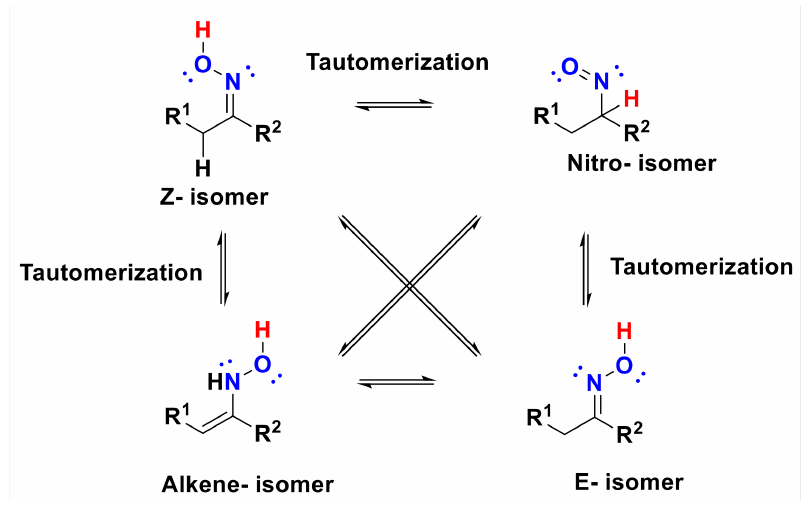
Figure 4. Isomerism in